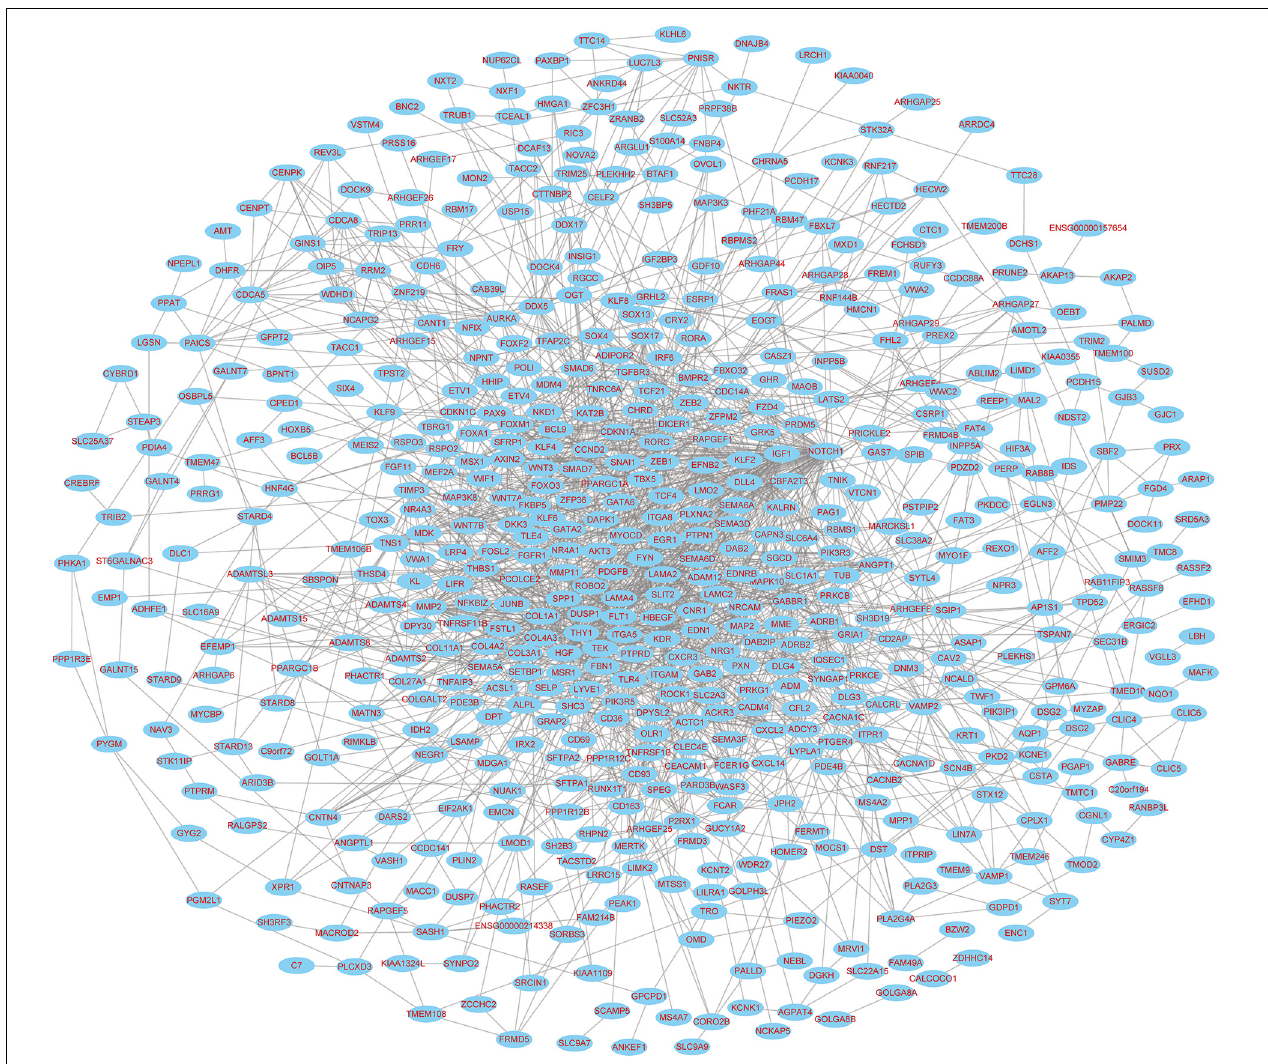
FIGURE 5 | PPI network diagram of targeted mRNAs from the hub miRNAs. PPI, protein–protein interaction; miRNA, microRNA; mRNA, messenger